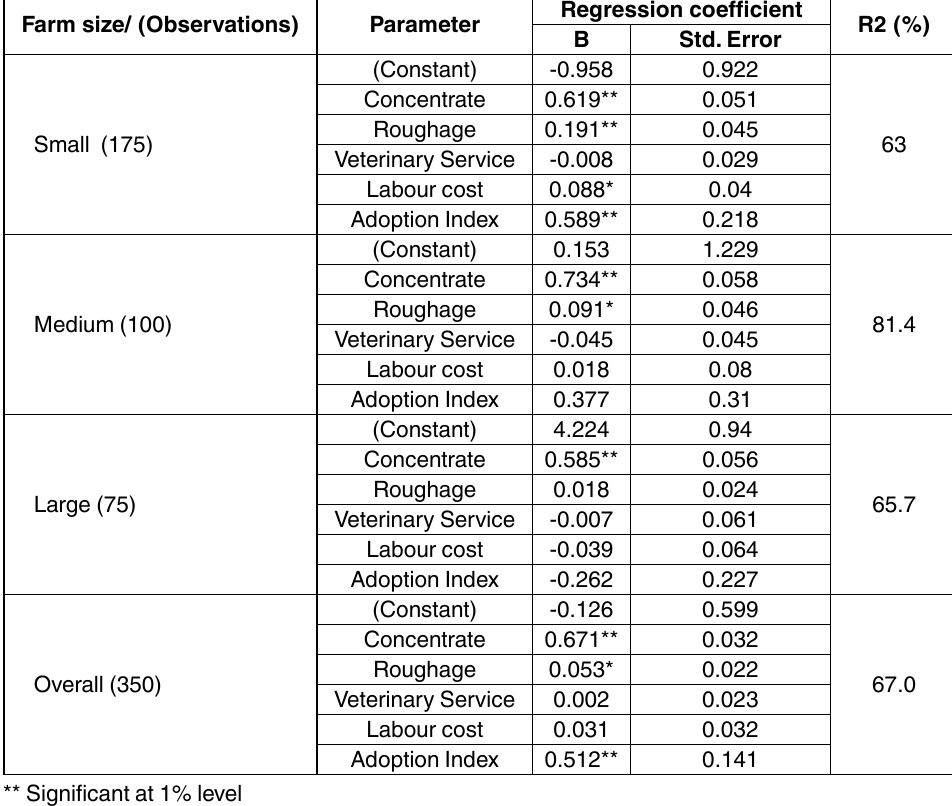
Table 1. Estimated Coefficients of milk production function Farm size/ (Observations)